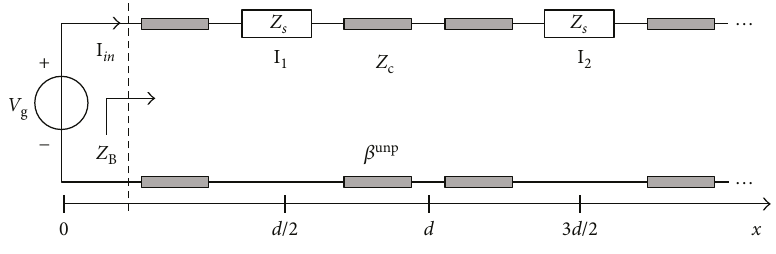
Figure 4: The equivalent circuit model of VICTS antenna. Table 1: Comparison of theoretical model and full-wave